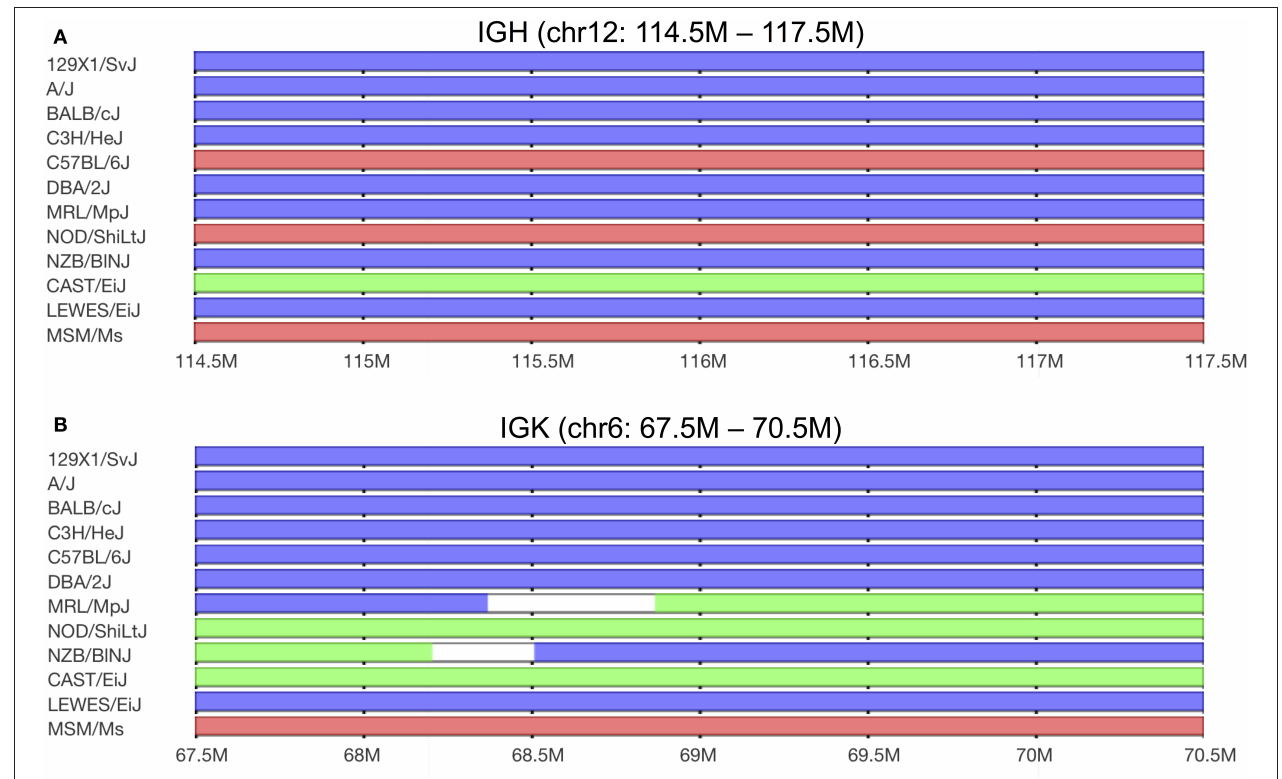
FIGURE 1 | Predicted sub-specific origins of germline haplotypes found in the (A) immunoglobulin IGHV and (B) immunoglobulin IGKV loci among selected classical inbred and wild-derived mouse strains. The MRL/MpJ strain is the parental strain of the MRL/lpr strain, and although MRL/MpJ mice carry a normal Fas gene, they are also prone to autoimmunity. The lowest three strains shown are wild-derived, with genomes that are representative of the three major subspecies. M. m. domesticus -derived sequences are shown in blue, M. m. musculus -derived sequences are shown in red, and M. m. castaneus -derived sequences are shown in green. Data from Yang et al. ( 30). Graphics by Mouse Phylogeny Viewer